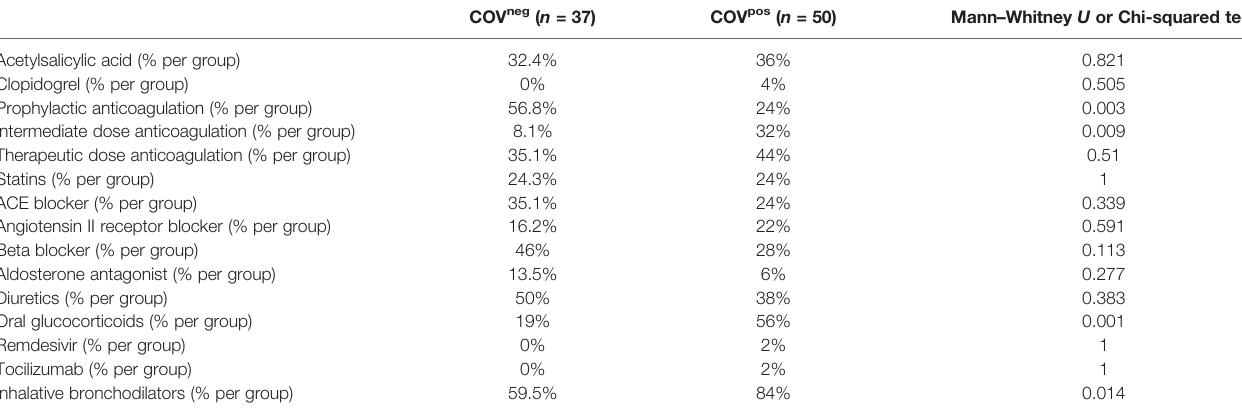
TABLE 2 | Patient characteristics — concomitant